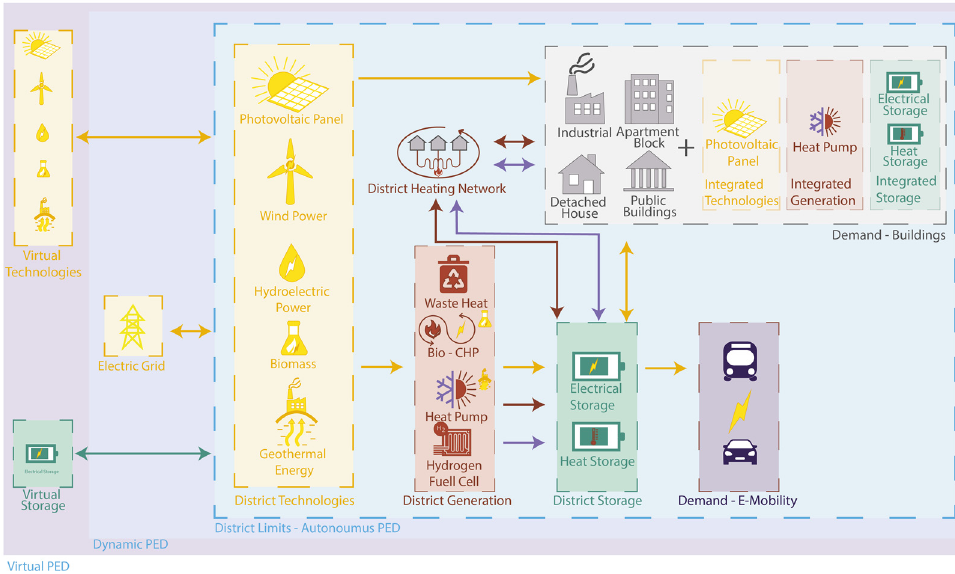
Figure 7. Summary diagram of the main technological choices in different typologies of PED.